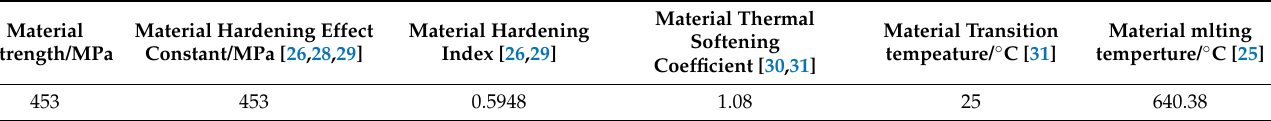
Table 4. Johnson–Cook constitutive equation parameters of 2A14-T4